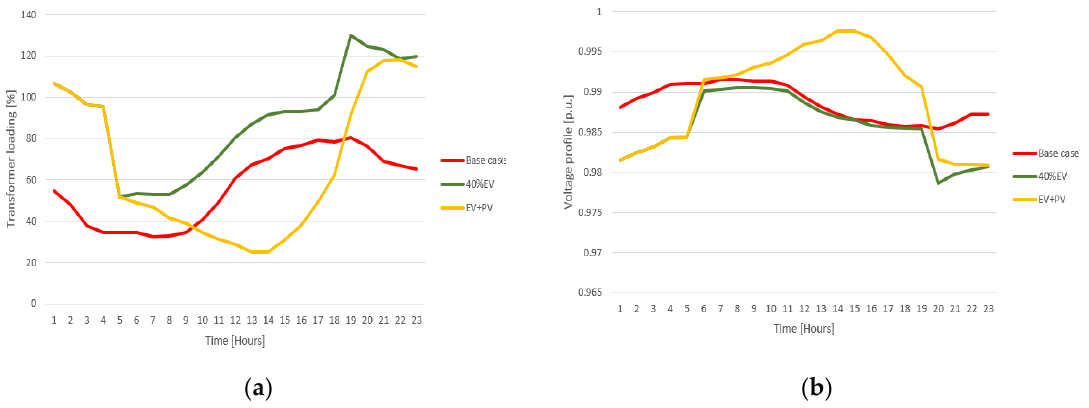
Figure 9. Comparison of urban ( a ) transformer loadings and ( b ) most loaded feeder voltage profiles with 40% EV penetration.